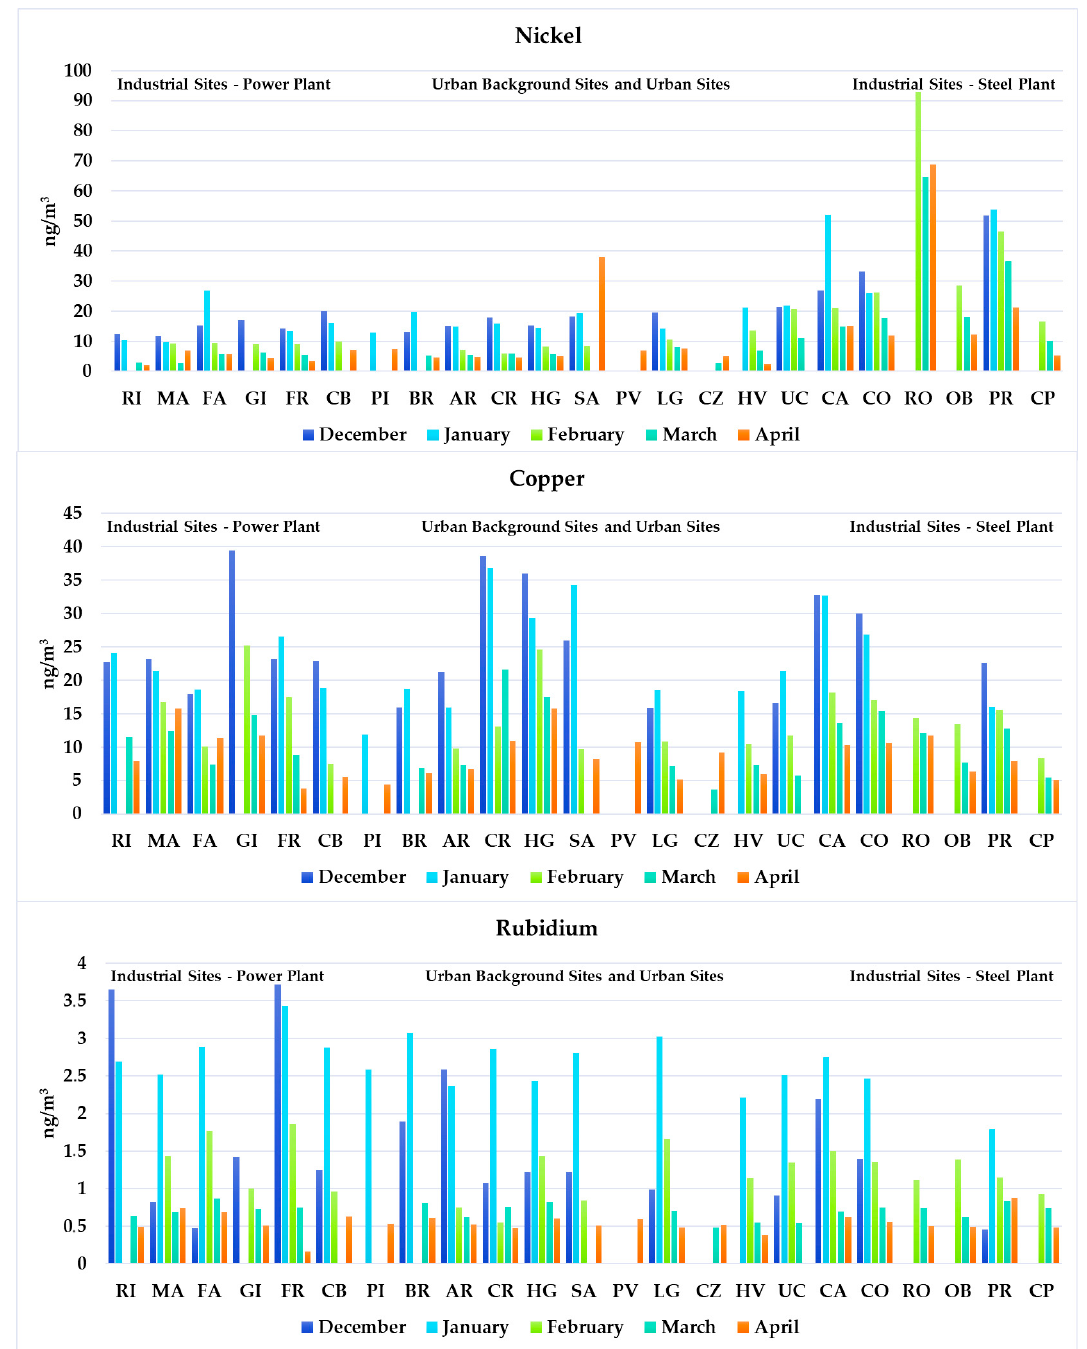
Figure 4. Variations of Ni, Cu and Rb monthly concentrations (ng/m 3 ) recorded during the five-month monitoring campaign at the 23 collection